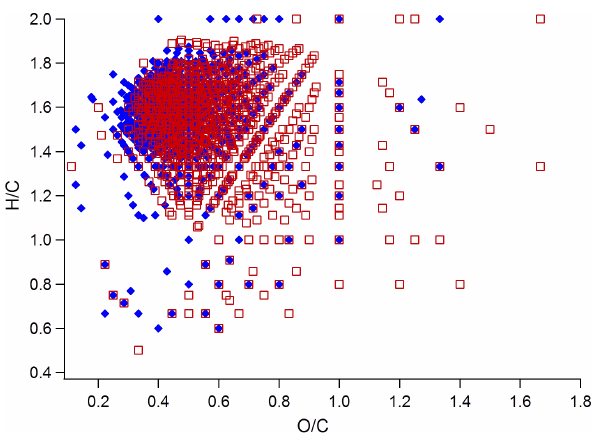
Figure 6. Van Krevelen diagram for molecules in SOA from ozonolysis (blue diamonds) and OH-initiated reaction (red squares) of α